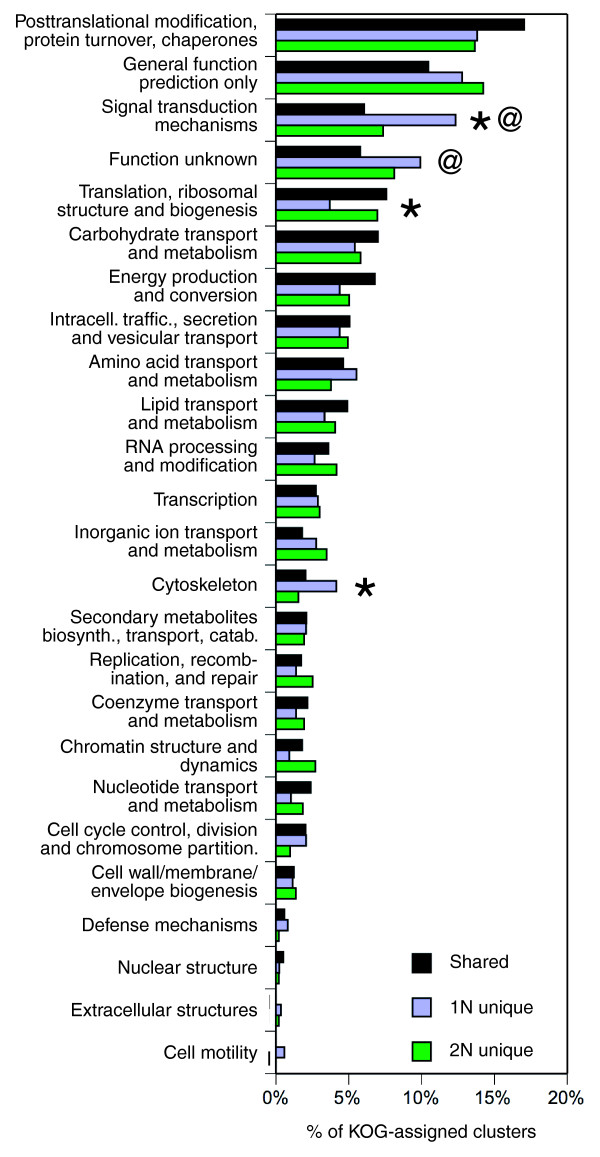
Distribution of clusters and reads by KOG functional class and library. Distributions of clusters over KOG class for clusters shared between the 1N and 2N libraries and clusters unique to each library. Fisher's exact test was used to determine significant differences in the distribution of clusters by KOG class between the 1N-unique and 2N-unique sets (asterisks indicate the KOG classes exhibiting significant differences between the 1N-unique and 2N-unique sets); P < 0.002 without correction for multiple tests). The same test was applied to determine differences in the distribution of clusters by KOG class between the set of shared clusters and both 1N-unique and 2N-unique clusters (the at symbol (@) indicates KOG classes exhibiting significant differences between the 1N-unique and shared sets; P < 0.002 without correction for multiple tests).